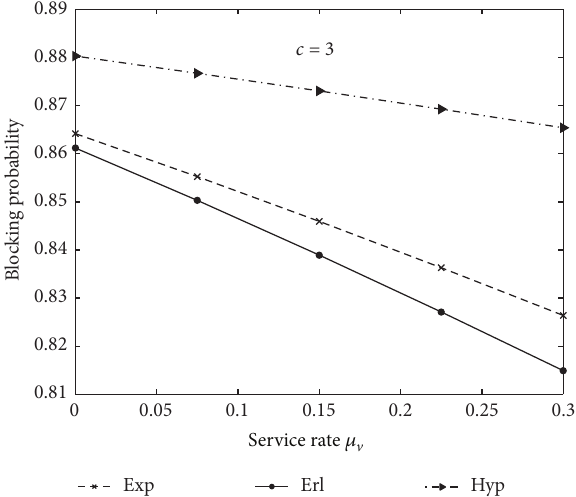
Figure 16: Mean number of busy servers versus vacation duration rate with 𝑐 = 1 , 𝜌 = 0.5 , 𝜉 = 0.1 , 𝜇 𝑏 = 10 , and 𝜇 V = 0.4